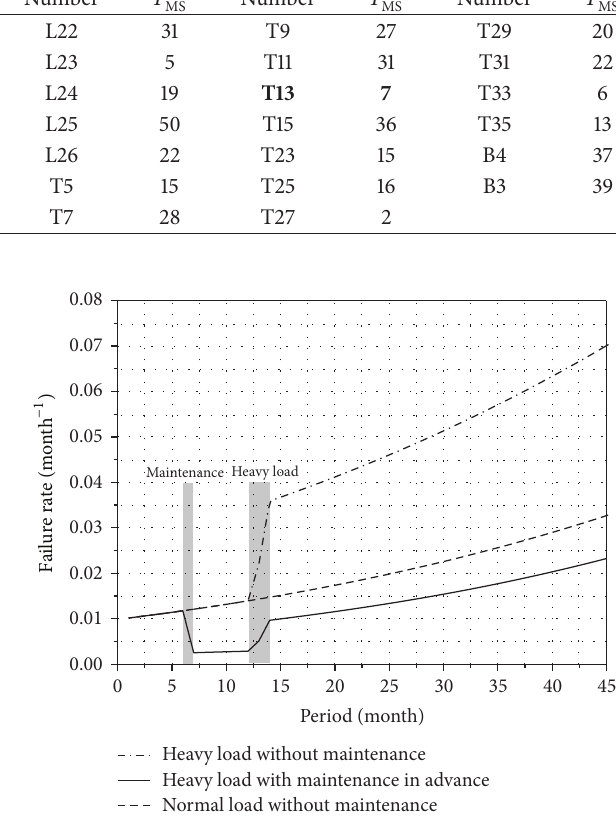
Figure 7: T13’s insulation failure rate change with heavy load and